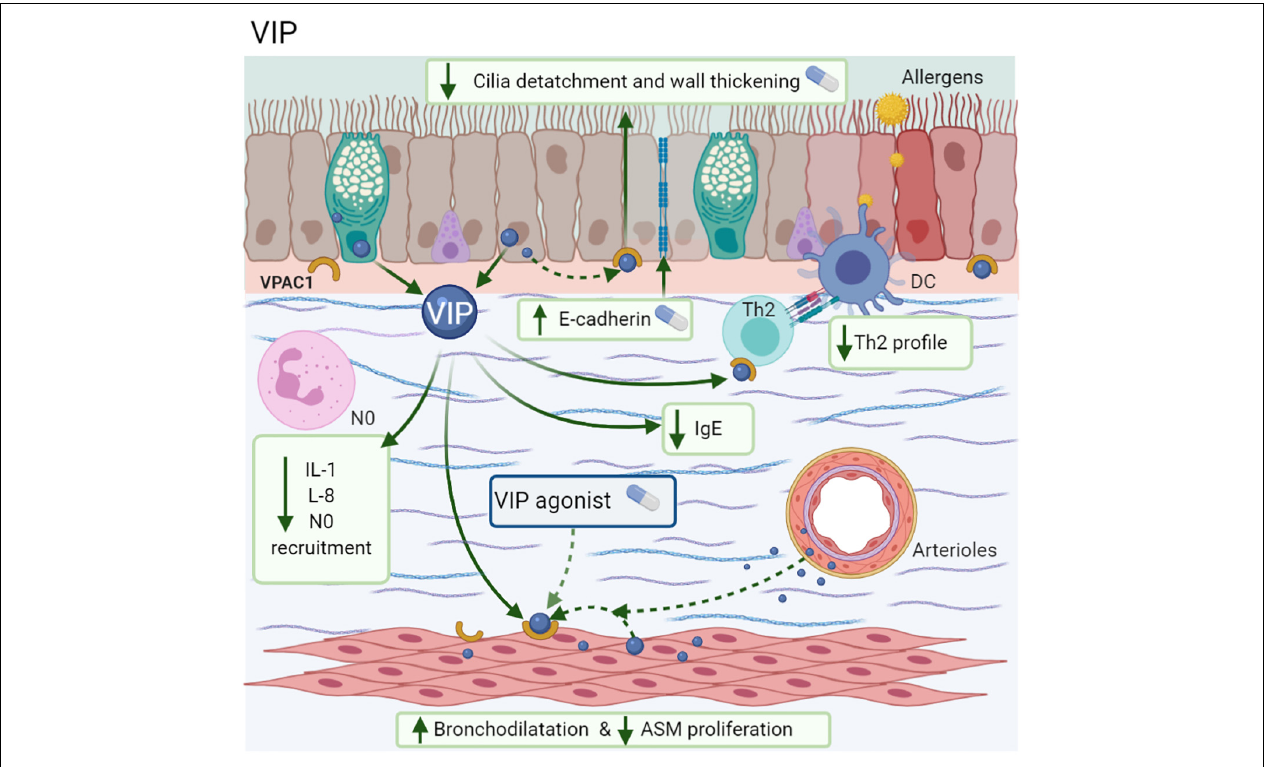
FIGURE 8 | Vasoactive intestinal polypeptide (VIP). VIP is synthesized by the epithelium, glands, ASM, arteriolar muscle, Th2 cells, and eosinophils; exerts its actions by VPAC1. Improves the bronchodilatation and repair of epithelium by E -cadherin expression; also decreases ASM proliferation, IgE, IL-1, IL-5, IL-13, diminishes the neutrophil